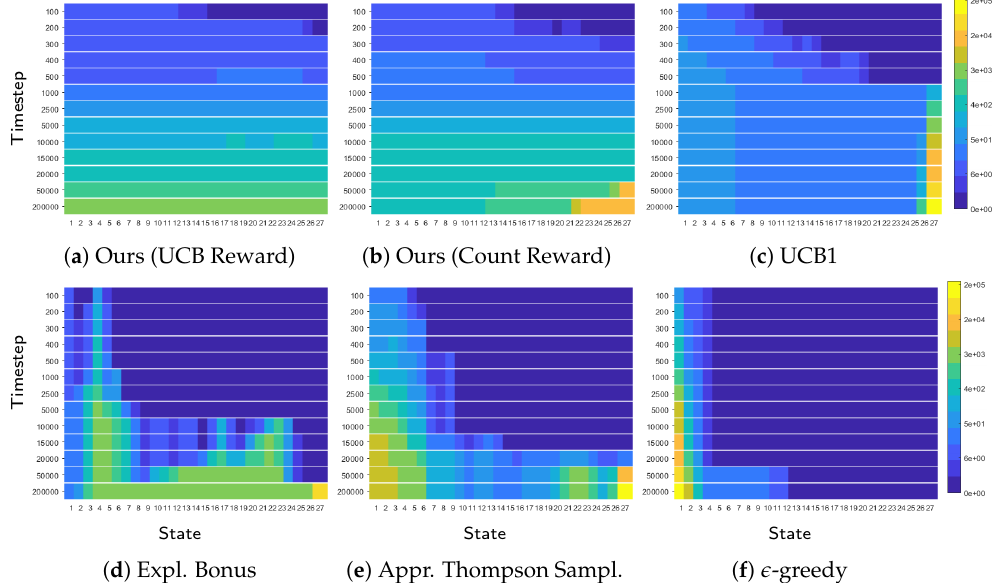
Figure 24. Visitation counts for the chainworld with 27 states (x-axis) over time (y-axis). As time passes (top to bottom), the visitation count grows. Only our algorithms and UCB1 explore uniformly, producing a uniform colormap. However, UCB1 finds the last state (with the reward) much later. Once UCB1 finds the reward (( c ), step 1000) the visitation count increases only in the last state. This suggests that when UCB1 finds the reward contained in the last state it effectively stops exploring other states. By contrast, our algorithms keep exploring the environment for longer. This allows the agent to learn the true Q-function for all states and explains why our algorithms achieve lower sample complexity and